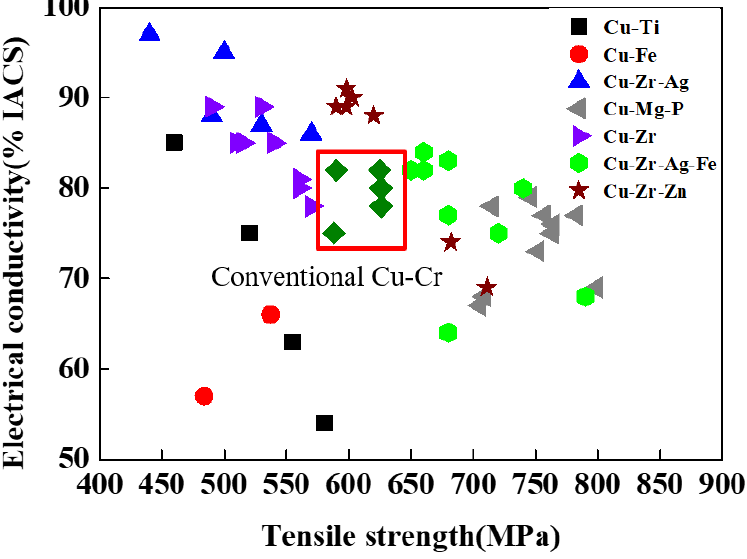
Figure 1. Conventionally used and recently developed Cu-Cr alloys and their properties.